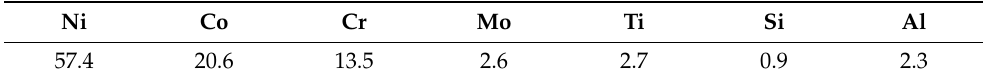
Table 2. Chemical composition of tested alloy (%).